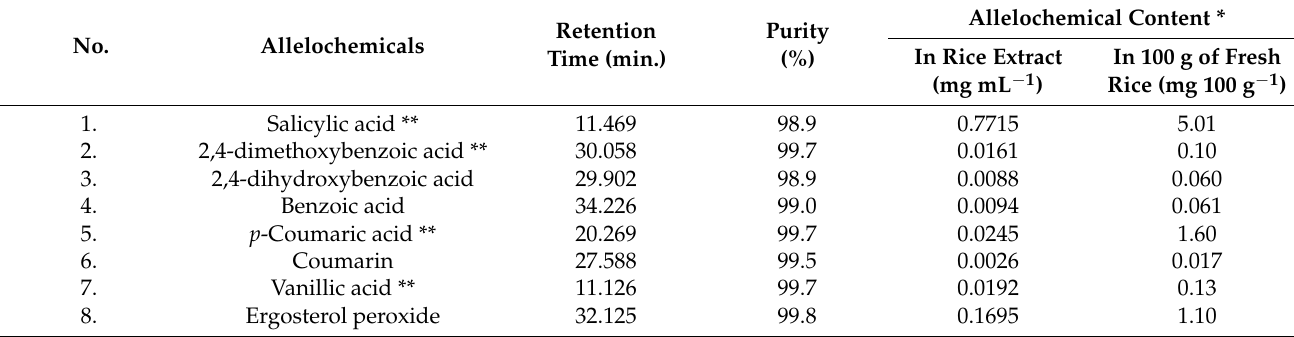
Table 4. List of allelochemicals detected in 100 g of OM 5930 by HPLC